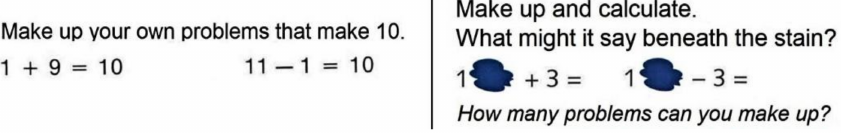
Figure 14. Assignments for own productions in WiG1 (1980s, left, Grade 1, student book 1b, p. 60) and RR2 (2000s, right, Grade 1, Student book 3b, p.